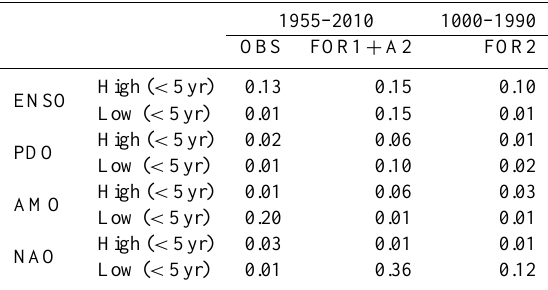
Table 3. Coefficients of determination R 2 between the global OHC700 and a selection of climate indices filtered separately at high ( < 5yr) and low ( > 5yr) frequency. Significance is assessed as in Table